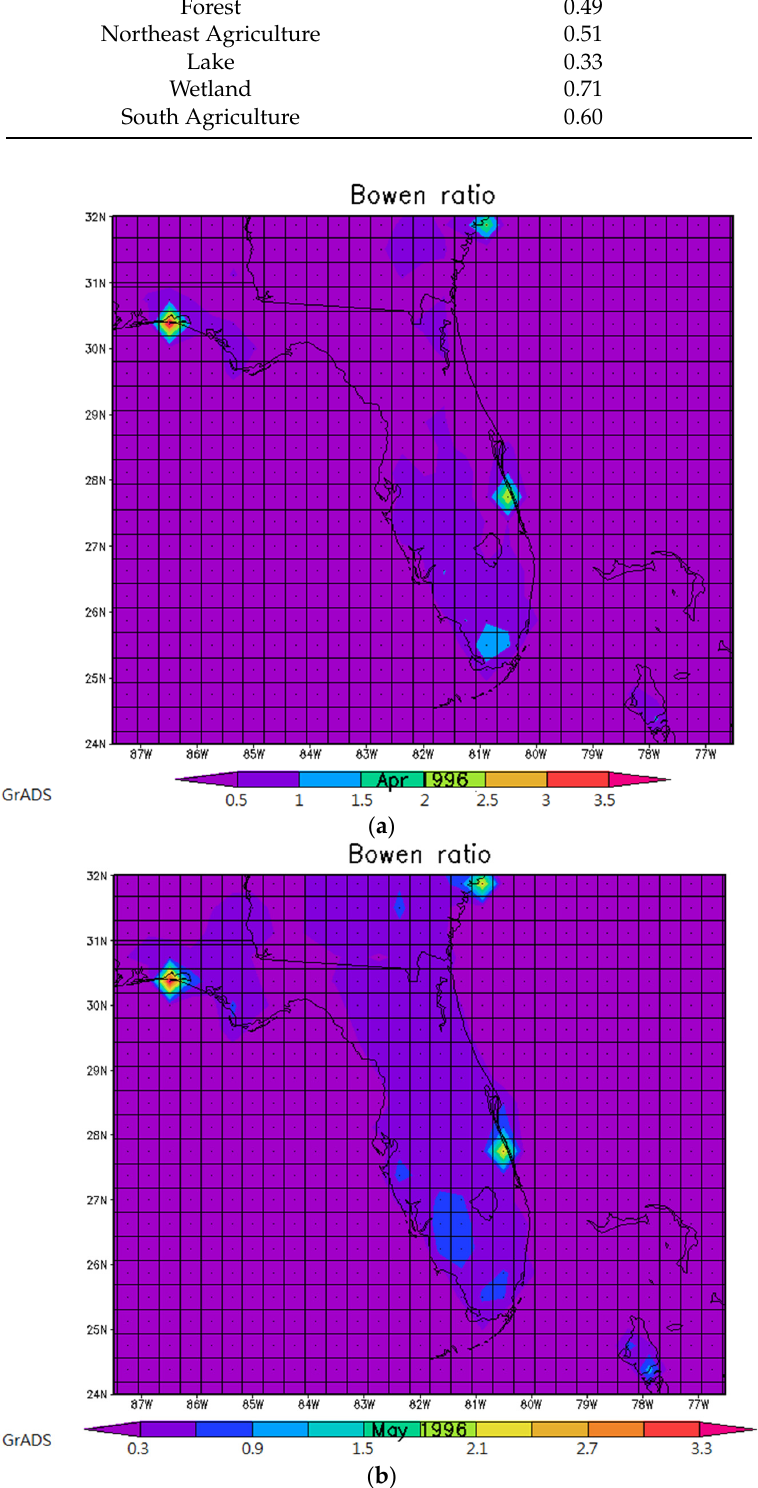
Figure 9. ( a , b ) Maps of Bowen Ratio in ( a ) April and ( b ) May 1996 over Florida.